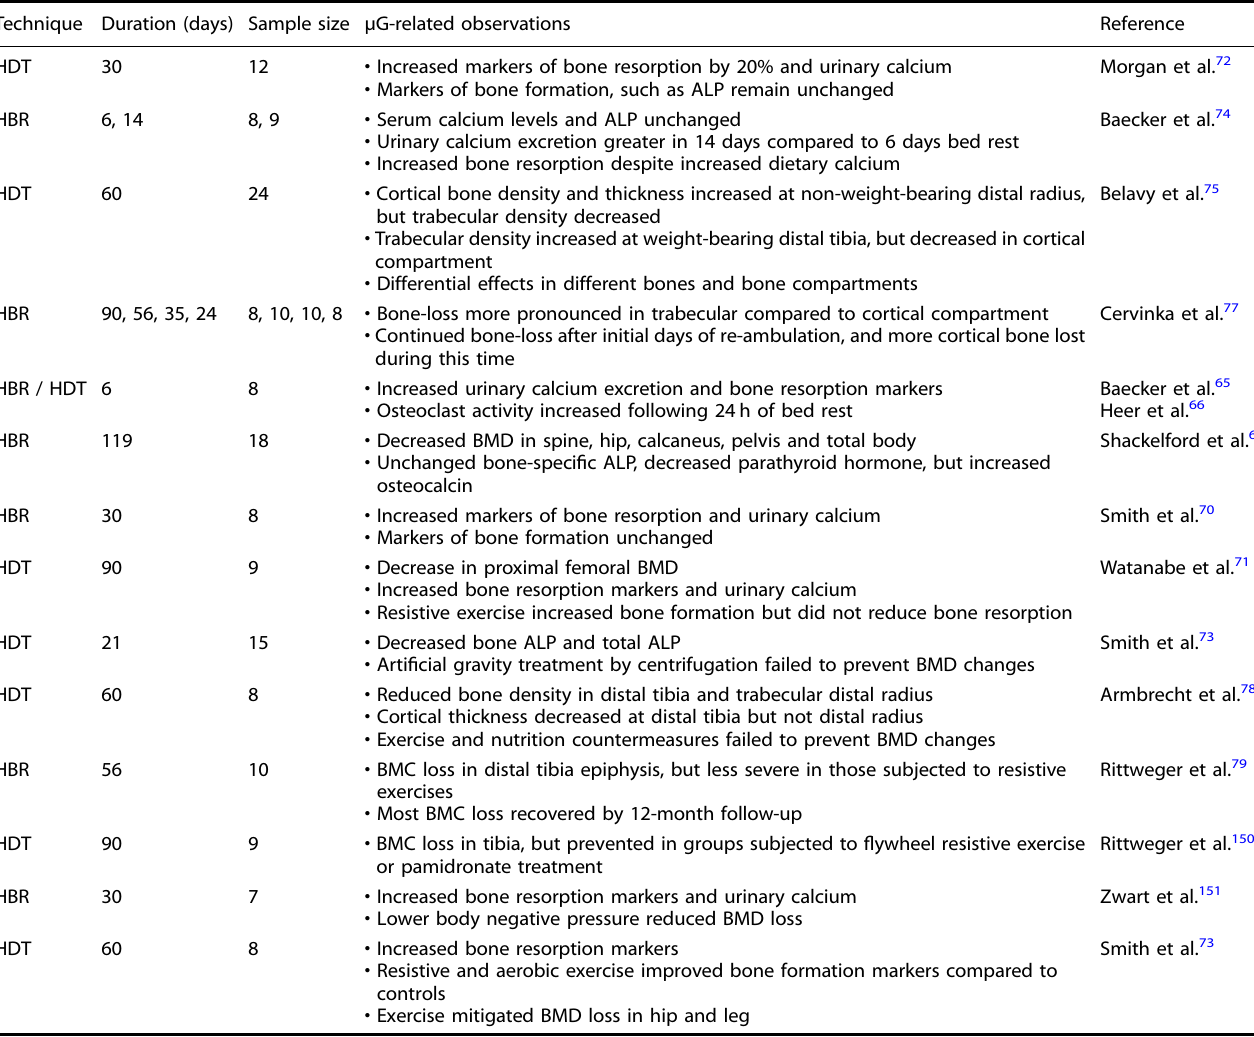
Table 3. Studies of bone-loss in humans subjected to simulated